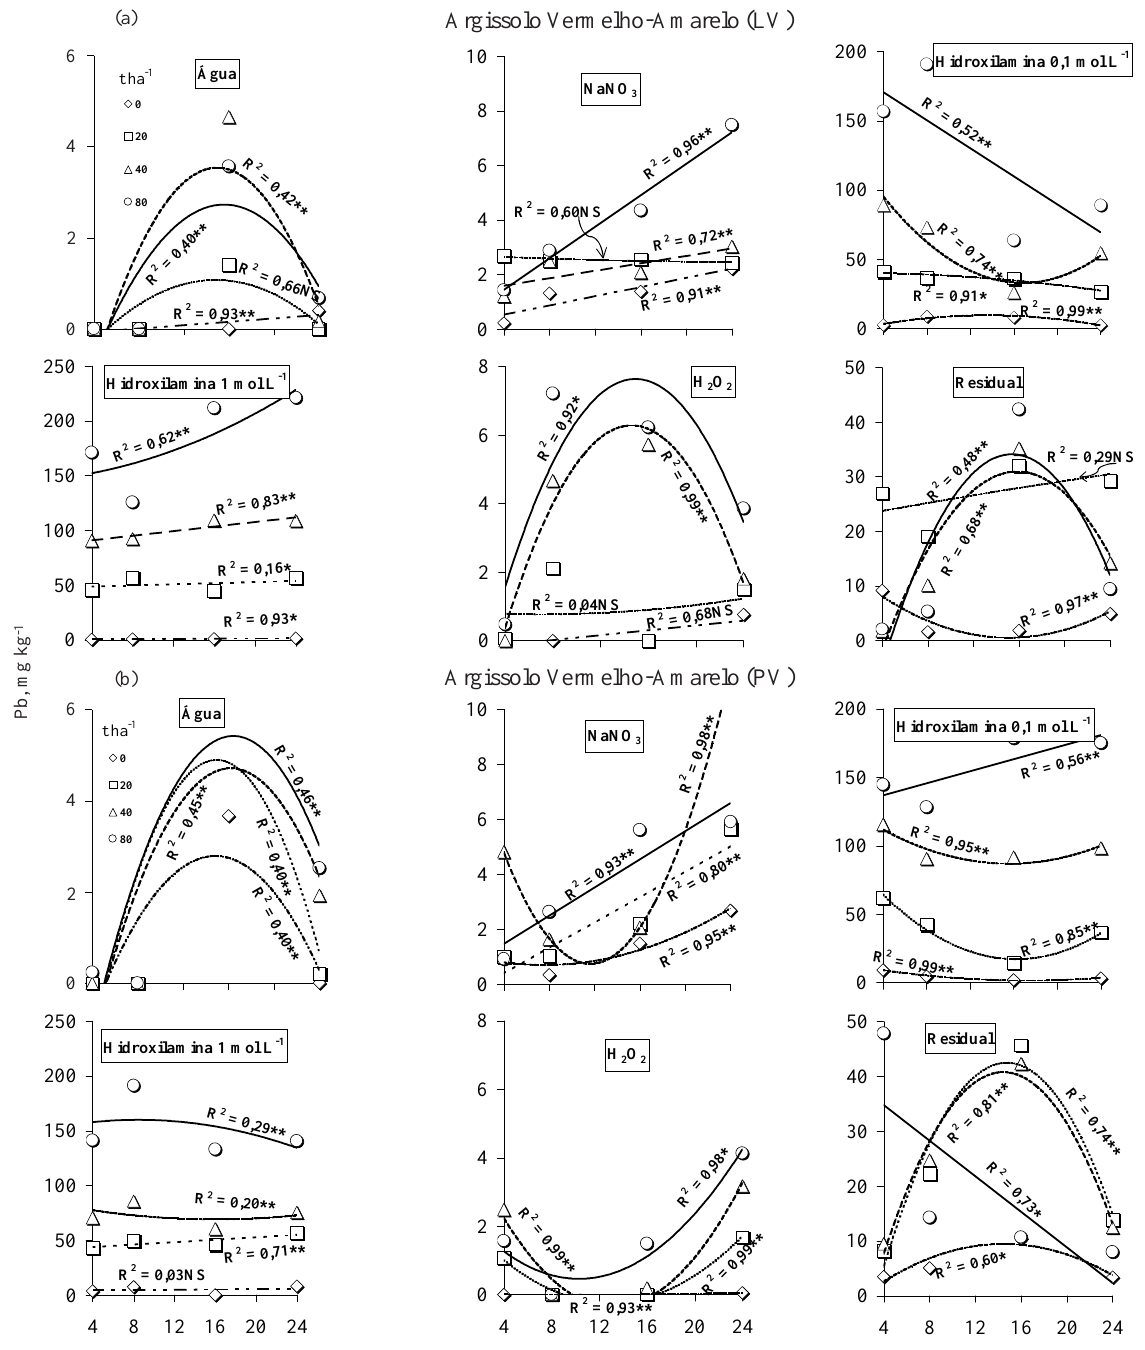
Figura 3. Efeito de tempo de incubação e dose de lodo de esgoto na extração seqüencial de Pb nos solos LV(a) e